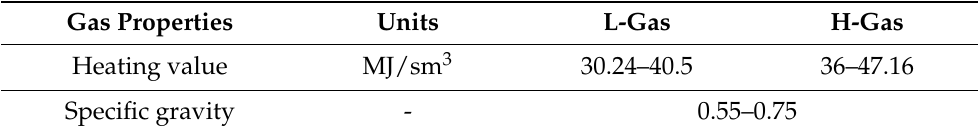
Table 1. Properties of natural gas in Germany